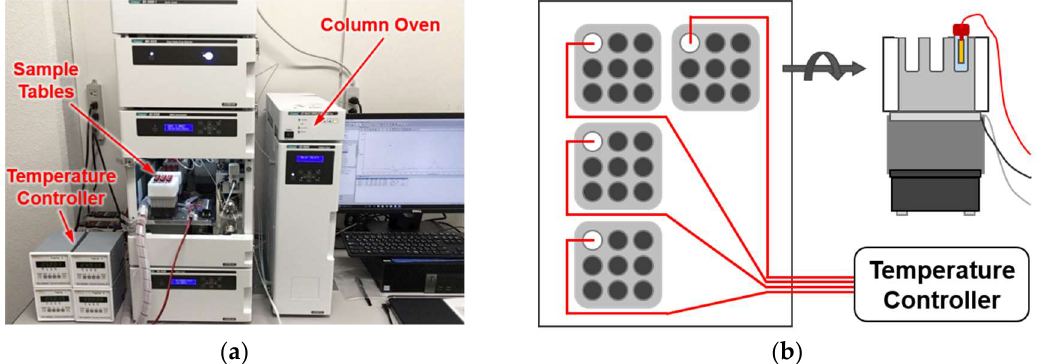
Figure 2. High-performance liquid chromatography (HPLC) system equipped with four-channel temperature controller. ( a ) Photograph of an HPLC equipped with four sample tables controlled independently at different temperatures. ( b ) Schematic top and side views of the four sample tables, each carrying nine sample holders thermostated by a Peltier device.